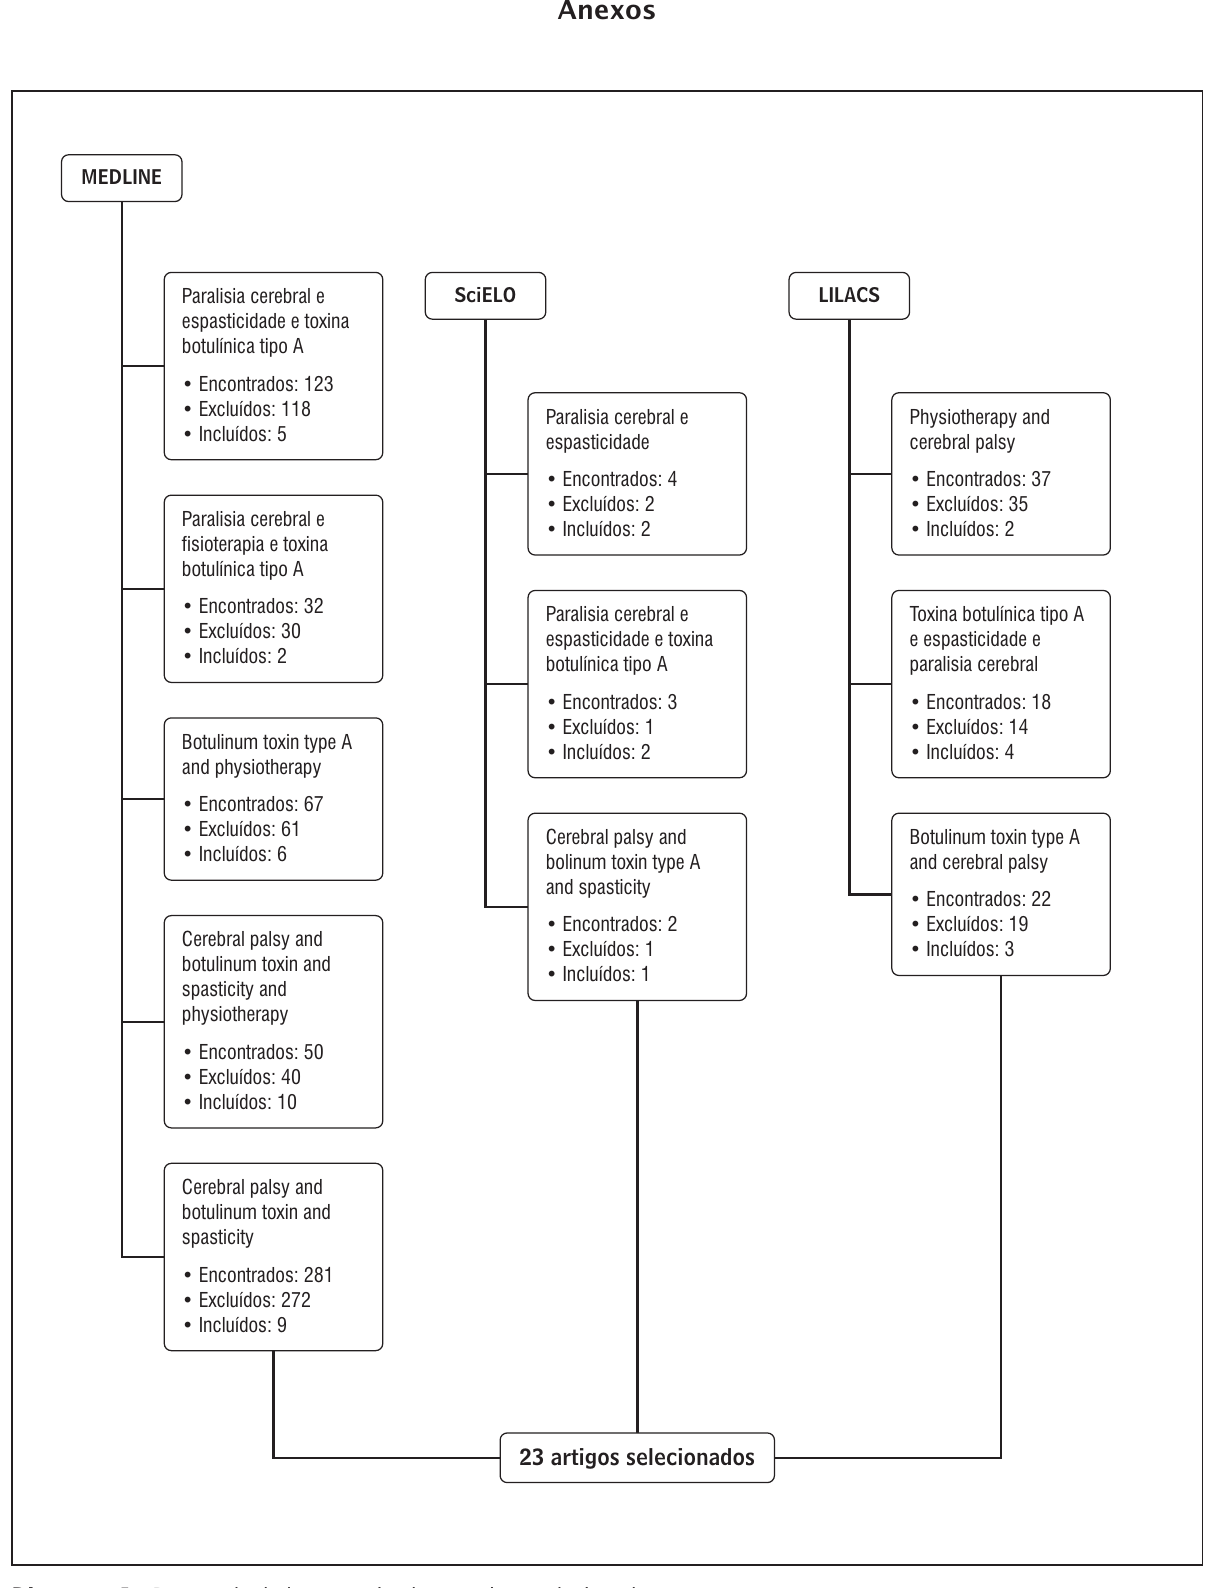
Diagrama 1 - Bancos de dados pesquisados e artigos